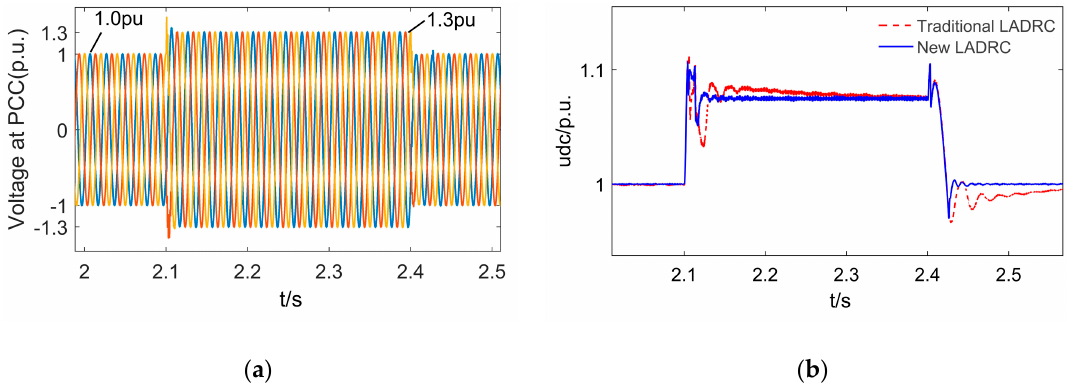
Figure 15. Dynamic response of a 1.5 MW permanent magnet synchronous generator (PMSG) with the traditional LADRC and new LADRC during the grid side voltage rising to 130%: ( a ) Voltage at Point of Common Coupling (PCC); ( b ) capacitor voltage u dc .